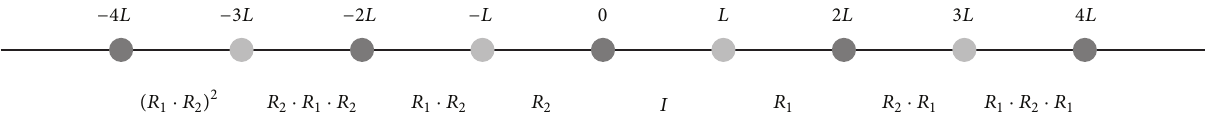
Figure 1: The fundamental region 𝐾 = (0,𝐿) and the virtual domains generated by the elements 𝑅 𝑖 ≡ 𝑅 𝑎